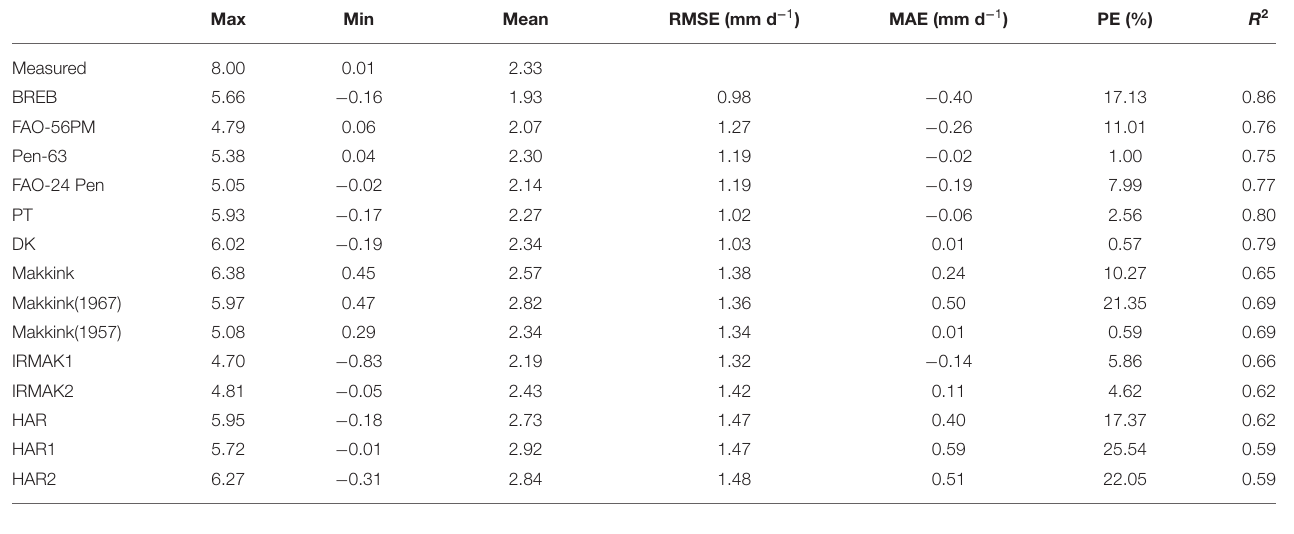
TABLE 3 | Summary of statistics for daily ET 0 between lysimeter measurements and model estimates during the whole study period (data points = 393). Model